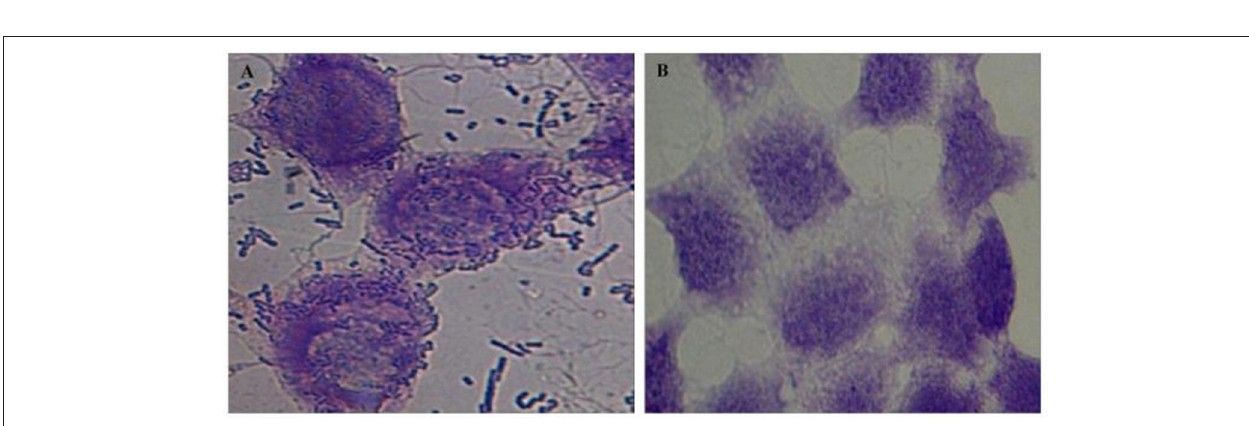
FIGURE 9 | Microscopic (1000X) image of Giemsa-stained intestinal cell line HCT-15 cells with (A) and without (B) adhered lactobacilli isolate